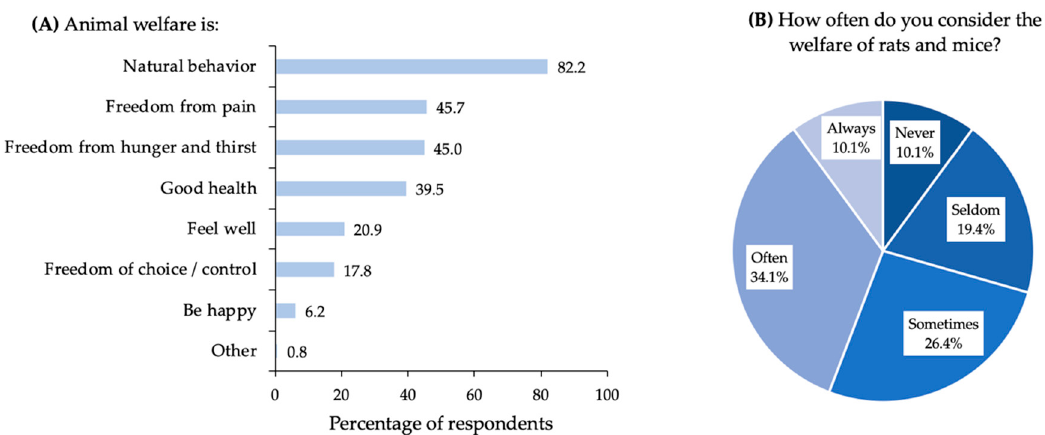
Figure 3. Panel ( A ): bar chart presenting the definition of animal welfare according to Dutch pest controllers. Respondents could choose a maximum of three aspects being important for their understanding of animal welfare. The numbers show the percentage of respondents who chose a certain aspect. In the survey, natural behavior was mentioned as the ‘Possibility to show natural behavior’. Panel ( B ): pie chart presenting how often the welfare of rats ( Rattus rattus and Rattus norvegicus ) and mice ( Mus musculus ) is considered by Dutch pest controllers. The results were obtained from 129 Dutch pest controllers who participated in an online survey.